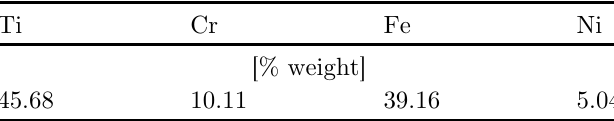
Table 3. Chemical composition of transition joint.